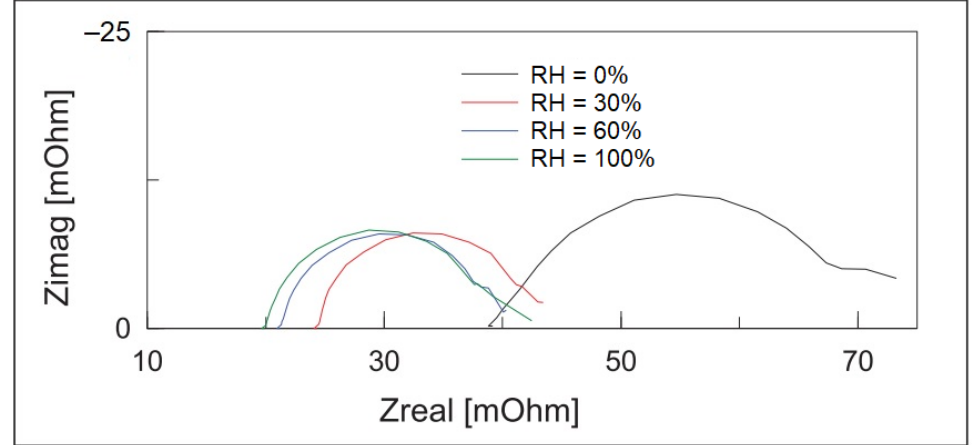
Figure 17. Nyquist plot (imaginary vs. real impedance) derived from electrochemical impedance spectroscopy (EIS) for a proton-exchange membrane in a fuel cell. Reprinted with permission from [155]. Copyright 2012, Elsevier.